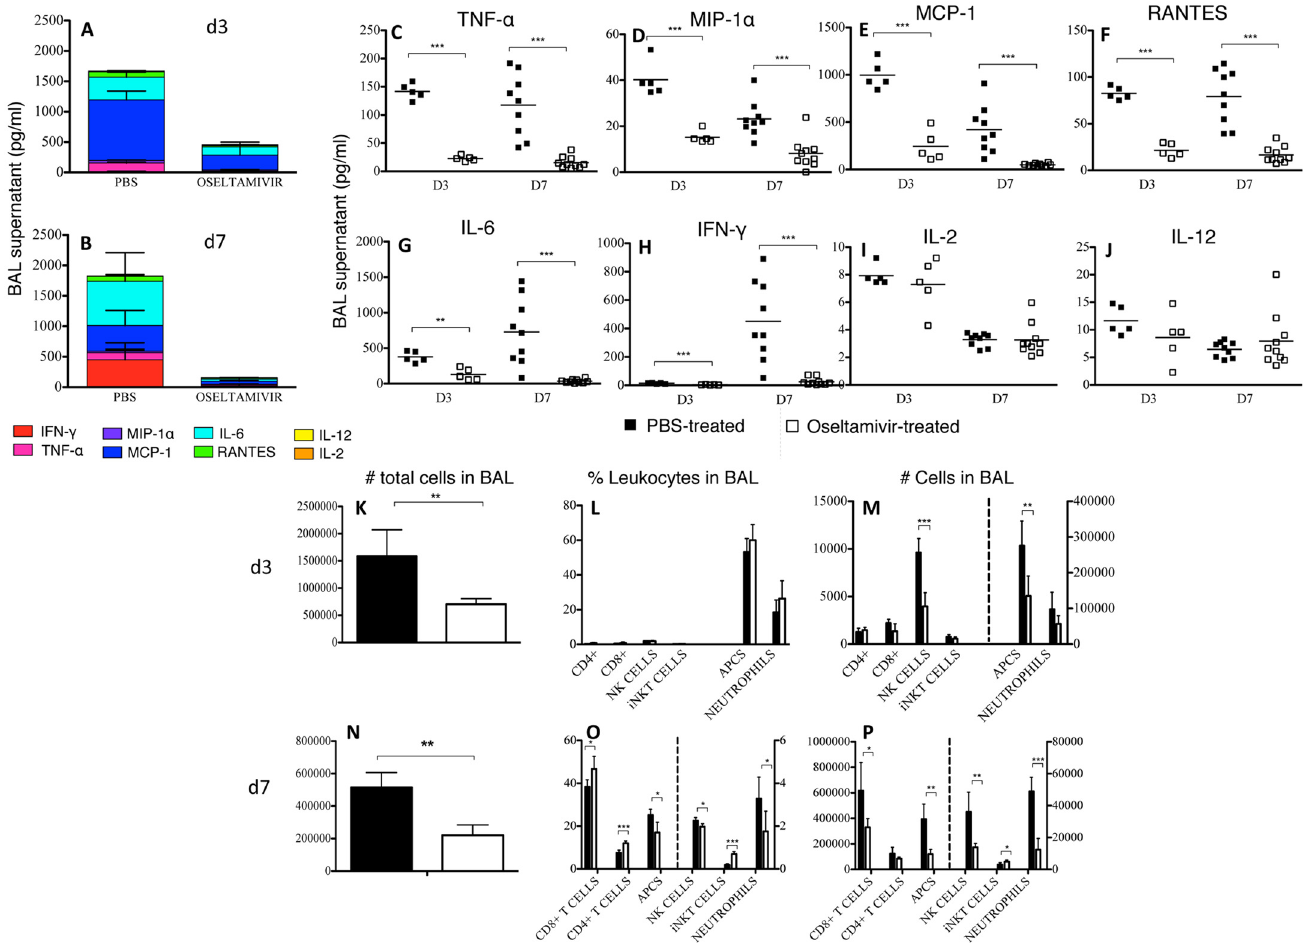
Fig 2. Reduced cytokine/chemokine levels and cellular recruitment to the airways of oseltamivir-treated mice. Mice received oseltamivir or PBS 4 hours prior to infection with 10 4 pfu of HK and once daily for 8 days thereafter. Clarified BAL supernatants were assayed by cytometric bead array for cytokine/chemokine concentration. Cumulative amounts and relative contribution of each cytokine or chemokine are demonstrated at (A) day 3, or (B) day 7 post-influenza infection in PBS- or oseltamivir-treated mice. Levels of (C) TNF- α , (D) MIP-1A, (C) MCP-1, (F) RANTES, (G) IL-6, (H) IFN- γ , (I) IL-2, and (J) IL- 12 in PBS- or oseltamivir-treated mice are also shown. Data comprise one to two separate experiments per time-point, each with 4 – 5 mice per group. Immune cells were enumerated by antibody staining and cell counts at (K-M) 3 days, and (N-P) 7 days after infection. * P < 0.05; ** P < 0.01; *** P <